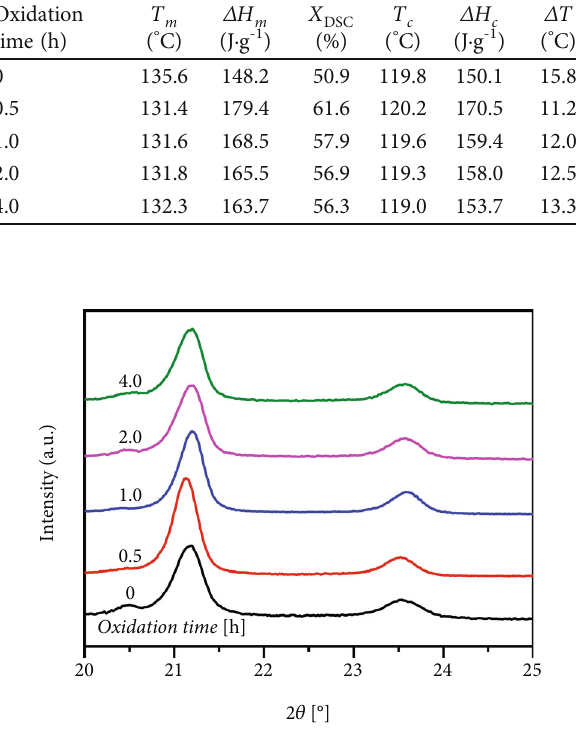
Figure 8: The XRD curves of GNP/oxidized UHMWPE composite.